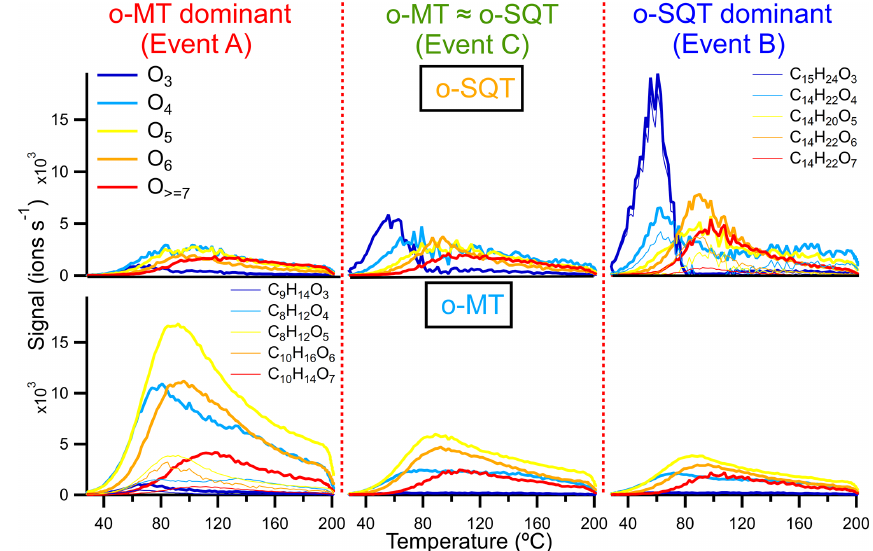
Figure 8. Thermograms obtained from the sum of subsets of o-SQT (C 13 − 15 H < = ( 1 . 75 × C ) O z ; top row) and o-MT (C 7 − 10 H y< = ( 1 . 8 × C ) O z ; bottom row) analytes during the events investigated in this study (A on the left, C in the center, B on the right). Each subset is the sum over chemical formulas with a certain number of oxygen atoms (indicated by colors). The thin lines represent the five most abundant o-SQT and o-MT compounds for each oxygen-containing subset (for clarity, only in the upper right and lower left panels, respectively) during the corresponding event